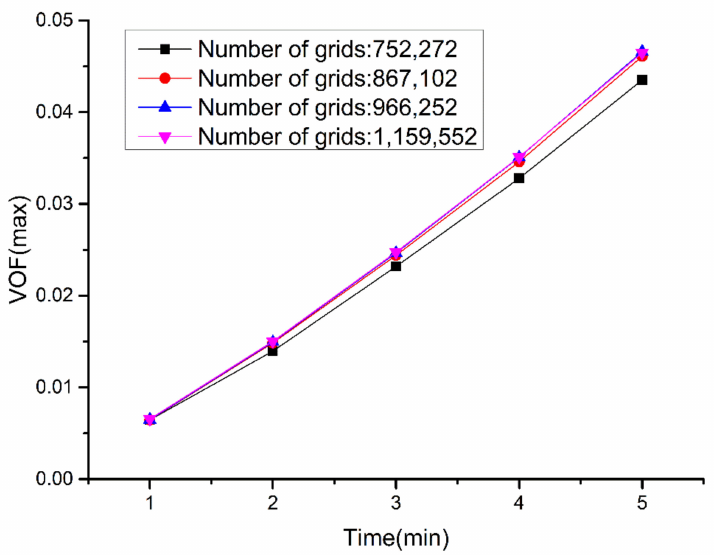
Figure 11. Variation of the maximum ice phase volume fraction at 5 min for different grid